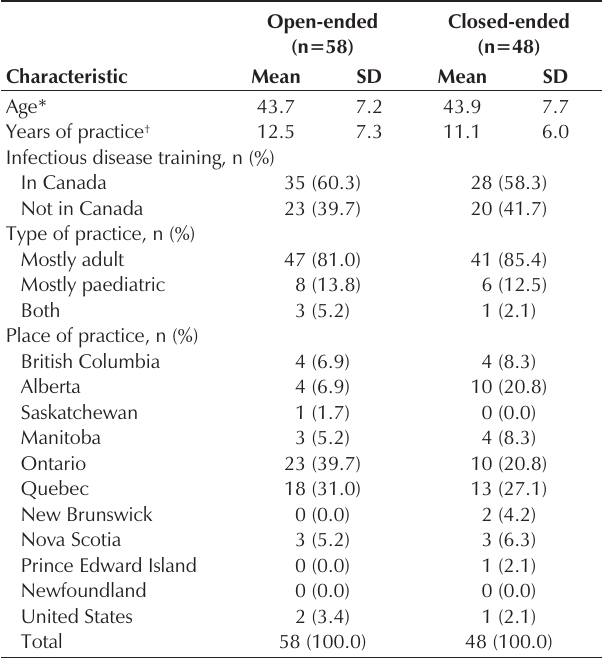
Characteristics of the respondents to survey on choice of antibiotic treatments